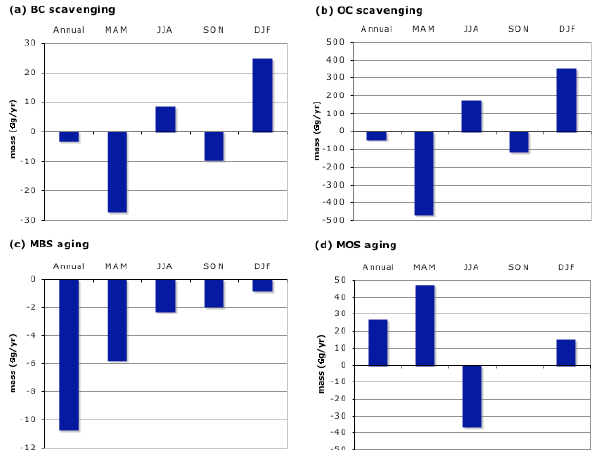
mixture (MOS), due to the seasonality of BBCA emissions.